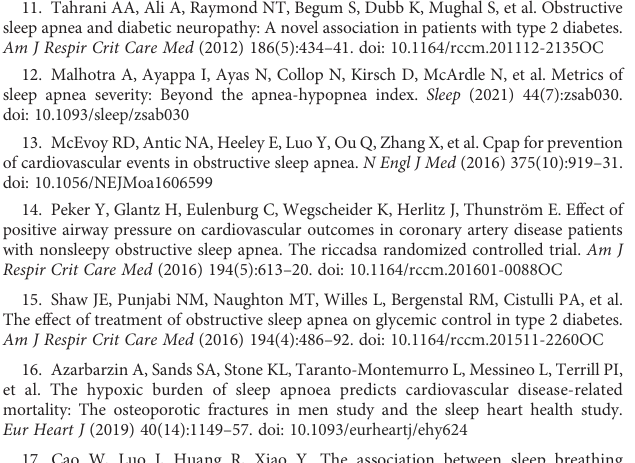
SUPPLEMENTARY FIGURE 1 Associations average respiratory duration and with BMI and WHR. (A) BMI in male, (B) WHR in male, (C) BMI in female, (D) WHR in female. Correlation was estimated by Pearson coef fi cient. BMI, body mass index; WHR, waist-to- hip